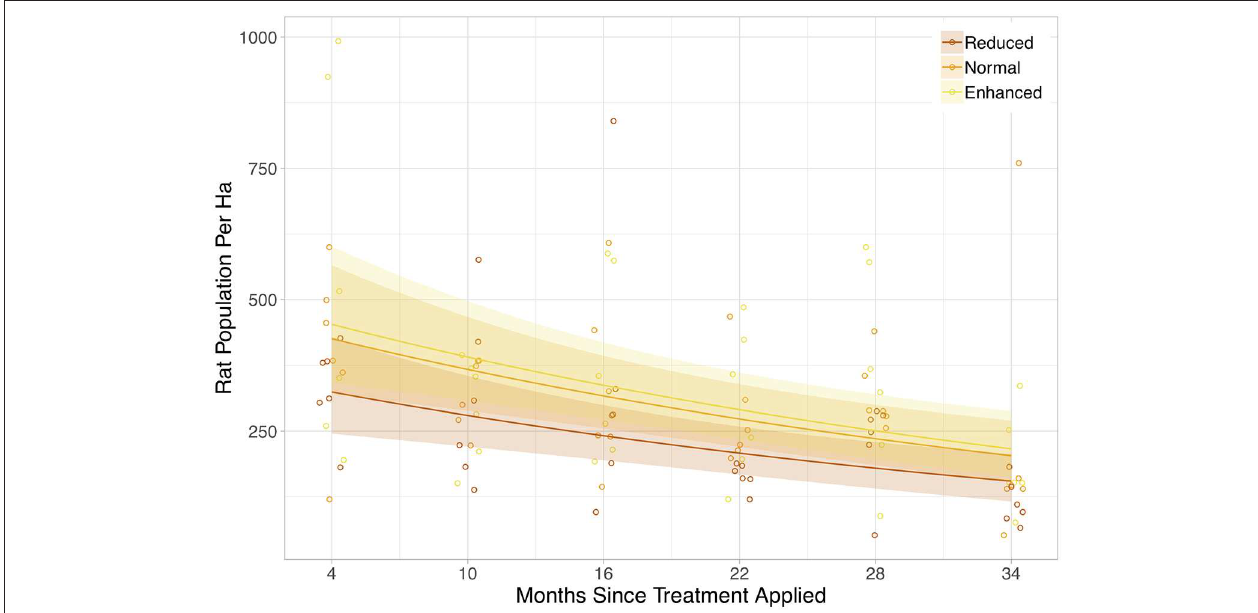
FIGURE 3 | Rat population per ha against time since the vegetation treatment was applied. The colored lines are the lines of best fit (Equation 3 in Supplementary Information , Equation 3a in Table 1 ), and shaded areas show 95% confidence intervals. The legend codes the three vegetation treatments. Points are jittered slightly along the x-axis for clarity. Each individual point represents a single plot, and all post-treatment time points are included.